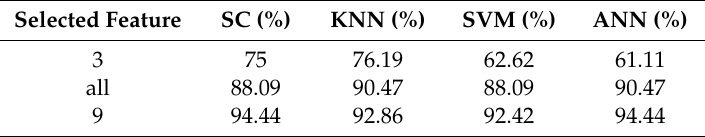
Figure 9. Multi-fault classification results. Table 2. Classification Accuracy for Multi-Fault.